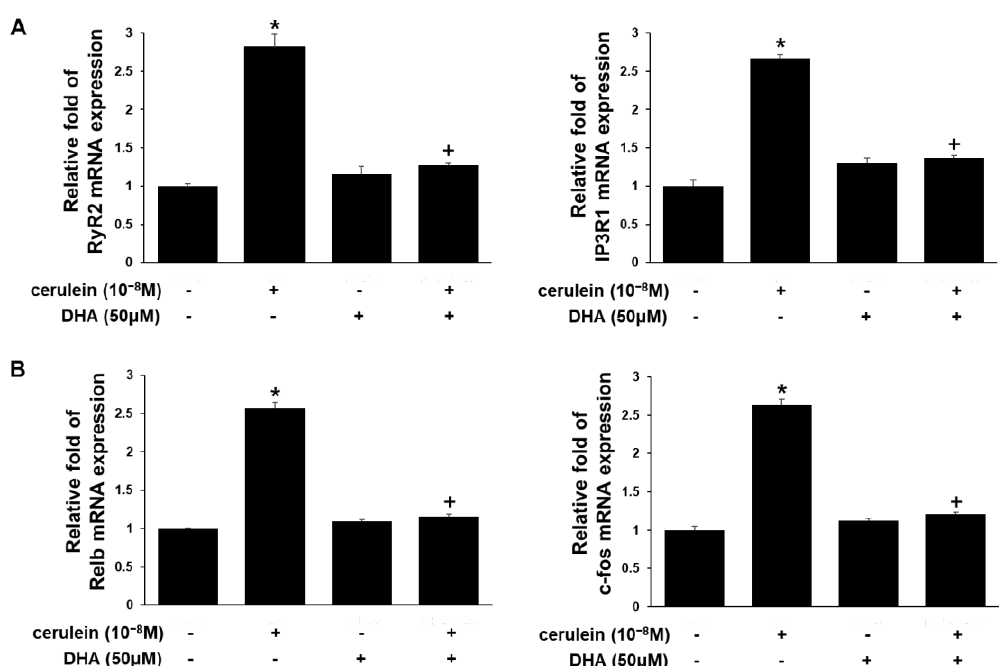
Figure 3. A chart of mRNA expression levels of the RyR2, IP3R1 (A), Relb, and c-fos (B) in AR42J cells. AR42J cells were treated with a vehicle or DHA (50 µ M) dissolved in vehicle for 6 h. For cerulein treatment, the cells were pretreated with a vehicle or DHA (50 µ M) dissolved in vehicle for 2 h and then stimulated with cerulein (10 − 8 M) for 4 h. Vehicle is 0.5 M ethanol. The mRNA levels were determined by real-time PCR analysis and normalized to the expression of the β -actin gene. * p < 0.05 vs. cells without treatment (cerulein-, DHA - ); + p < 0.05 vs. cells with cerulein treatment alone (cerulein + , DHA -). mRNA expression of the cells without treatment (cerulin-, DHA - ) was set at 1. Relative fold of each group was compared to that of the cells without treatment (cerulin- ,DHA - ).